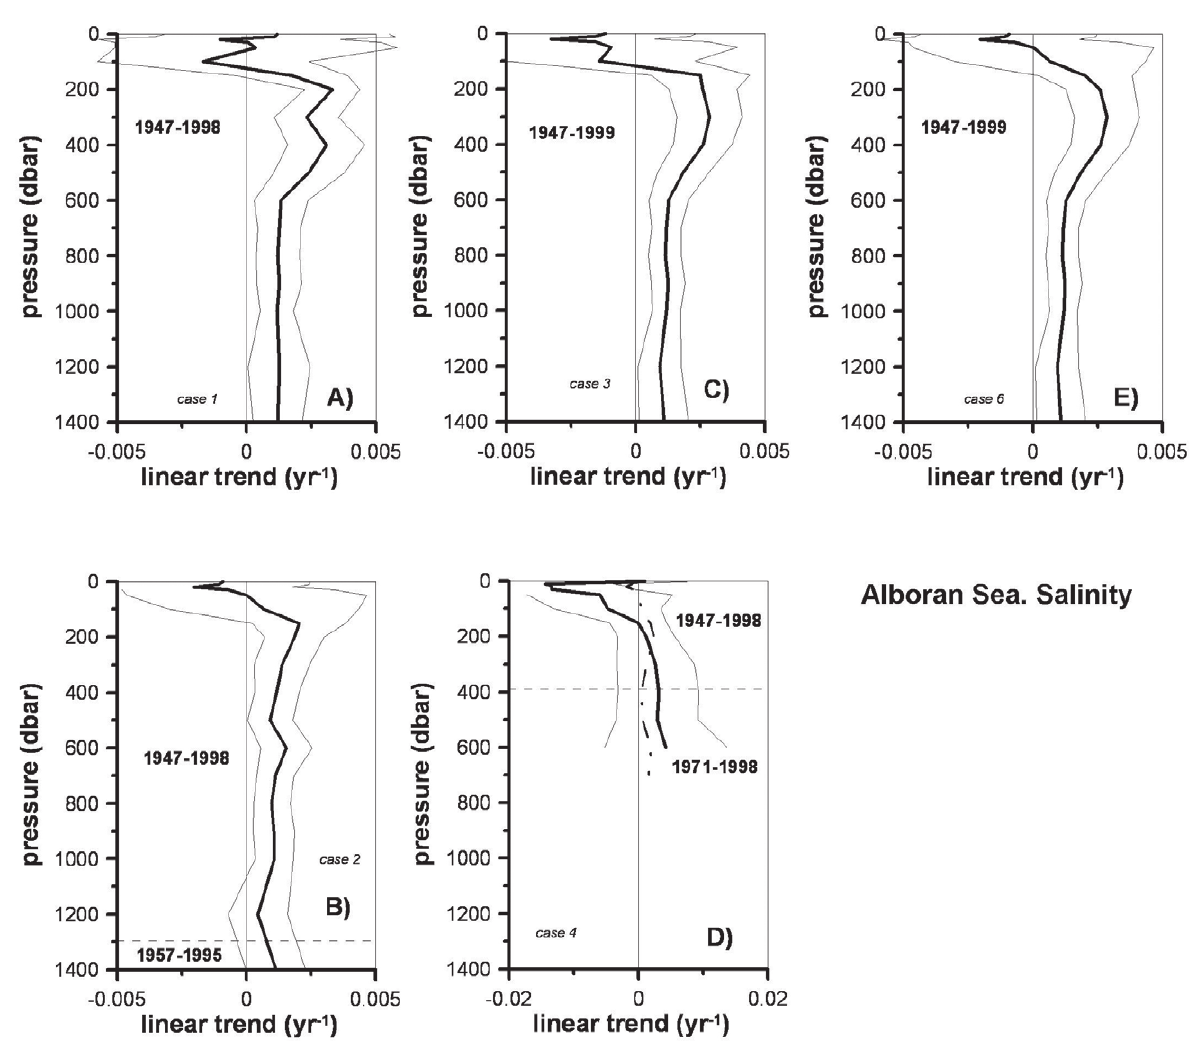
Fig . 7. – as in Figure 6, but for salinity trends in the alboran